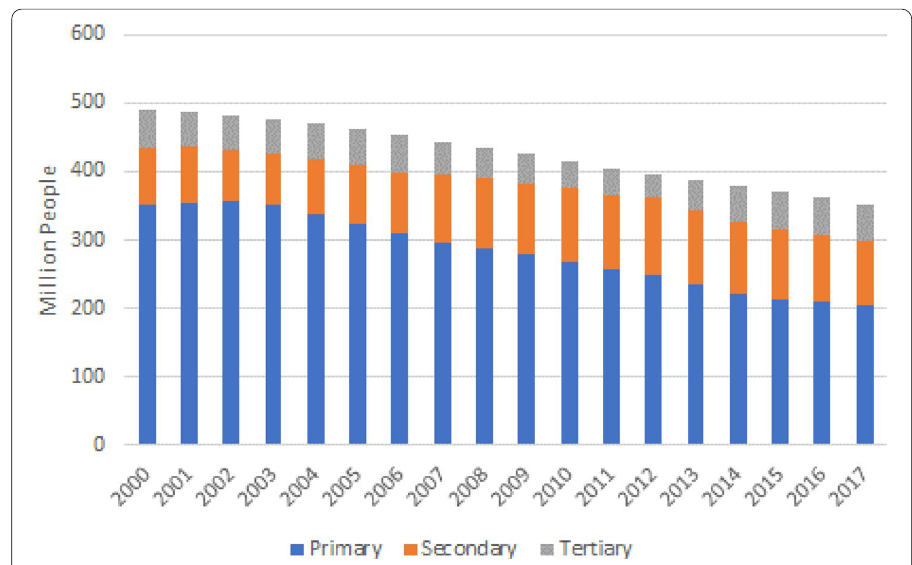
Figure 2 indicates the number of employees by sector in cities 10 ; it also describes